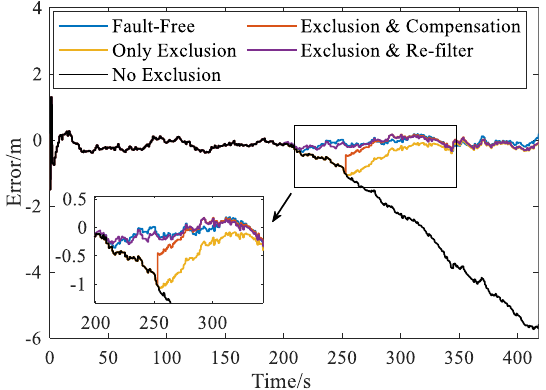
ff erent filter recovery